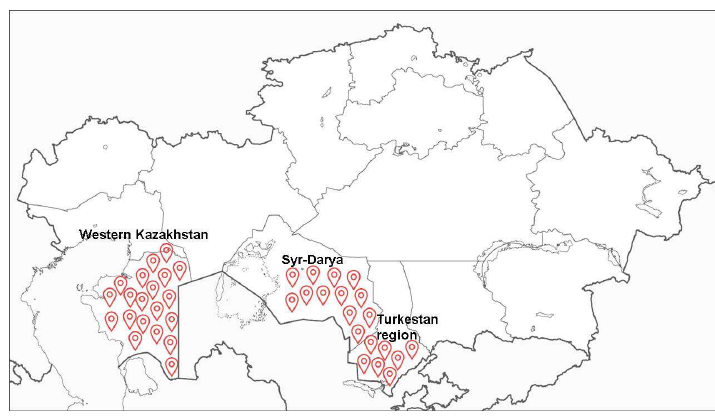
Fig. 1. Distribution map of Ferula asafoetida L. in Kazakhstan